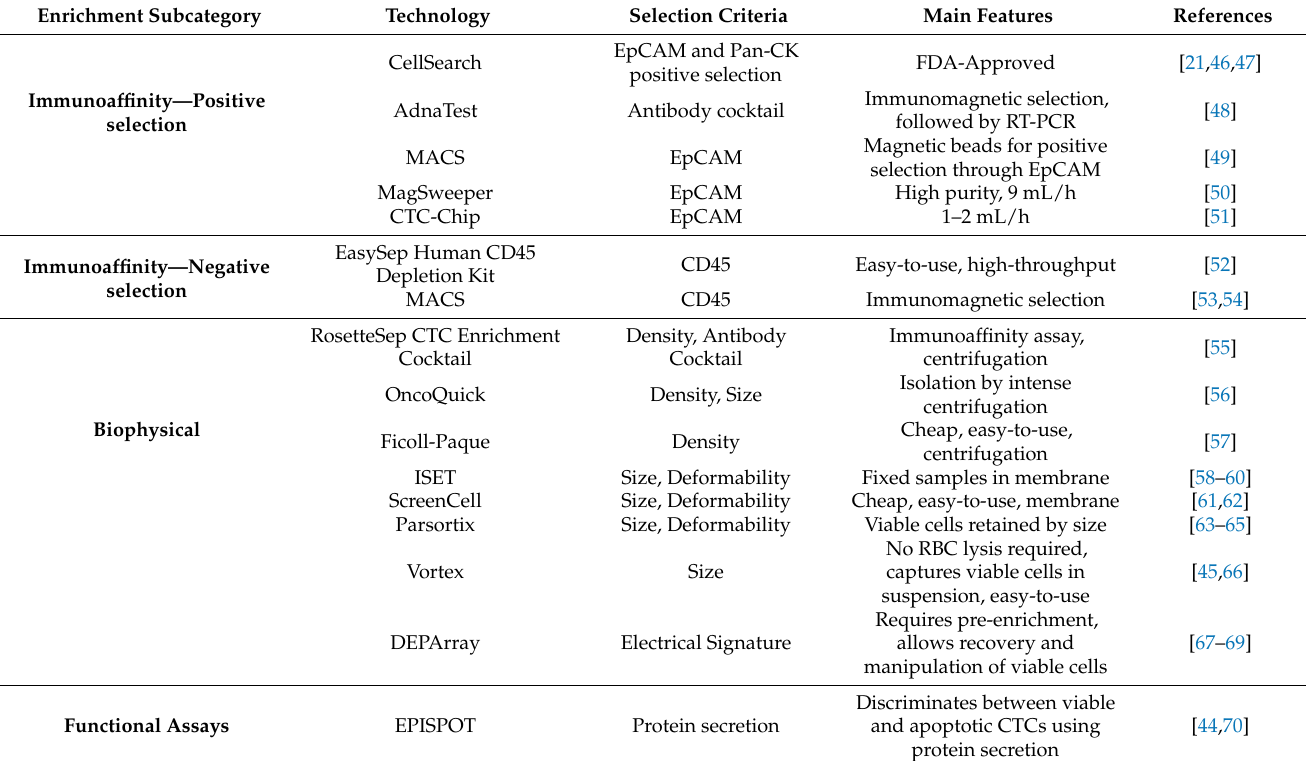
Table 1. CTC enrichment methods, organized by technology